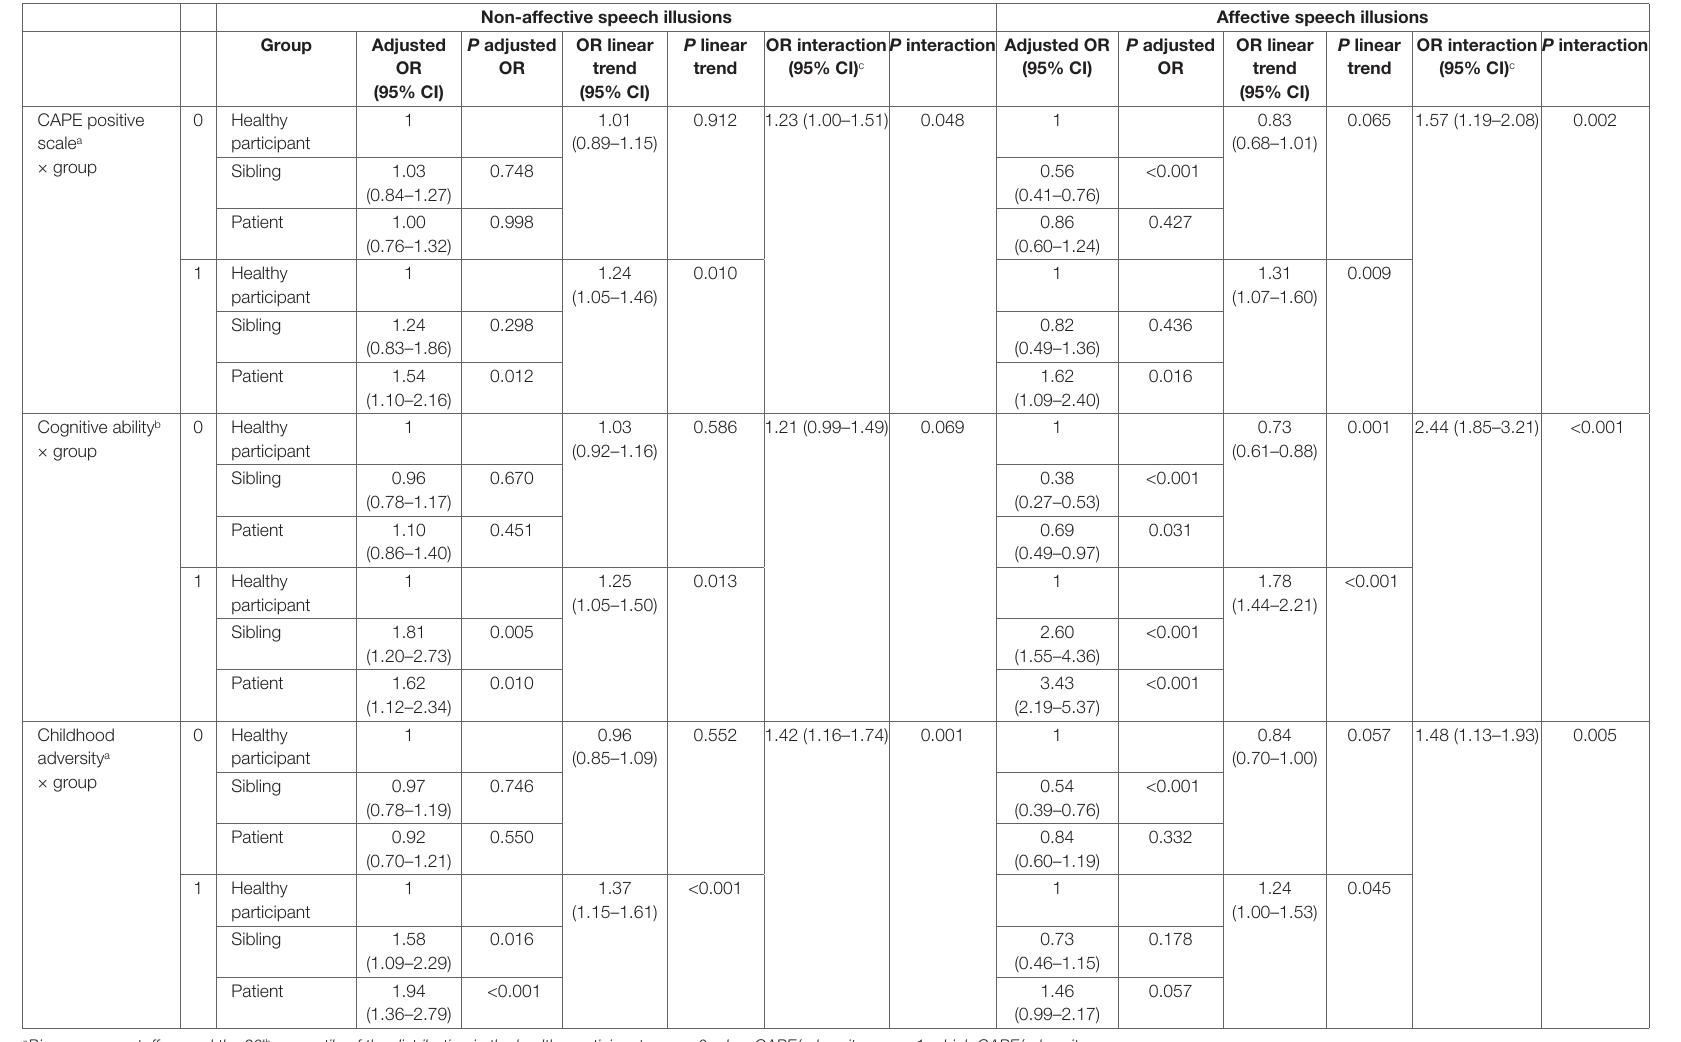
TABLE 4 | Interaction between group and CAPE positive scale, cognitive ability, or childhood adversity in (non-)affective speech